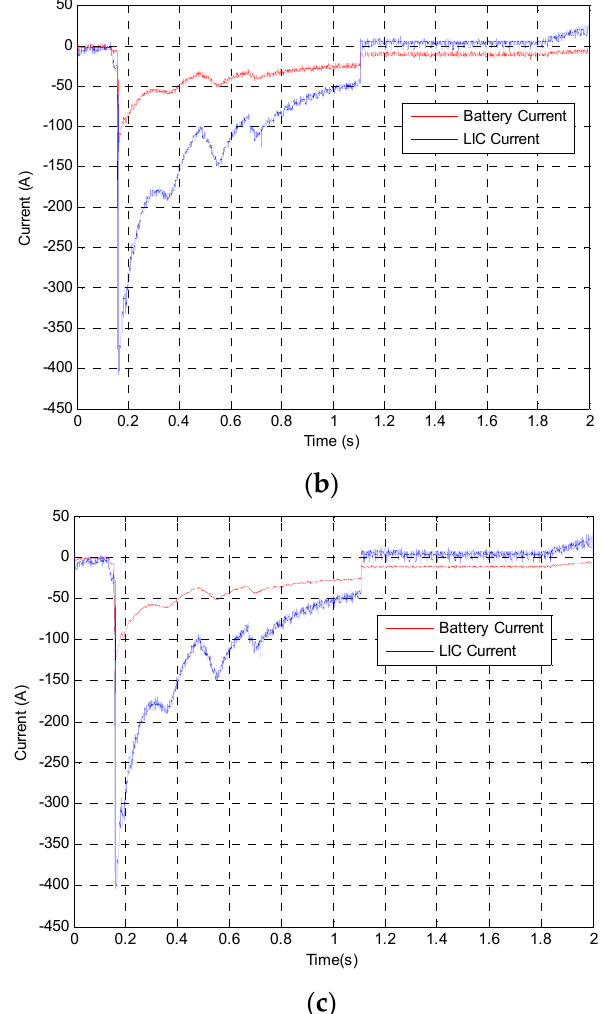
Figure 7. Ultracapacitor-biased connection: ( a ) connection diagram; ( b ) results; ( c ) simulation results.